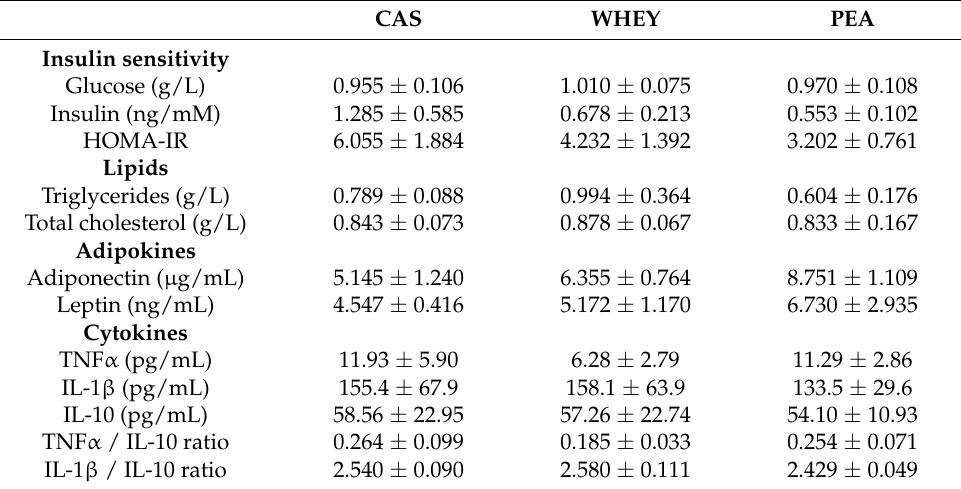
Table 7. Fasting metabolic parameters in plasma of old rats after the 16 weeks of different diets. CAS WHEY